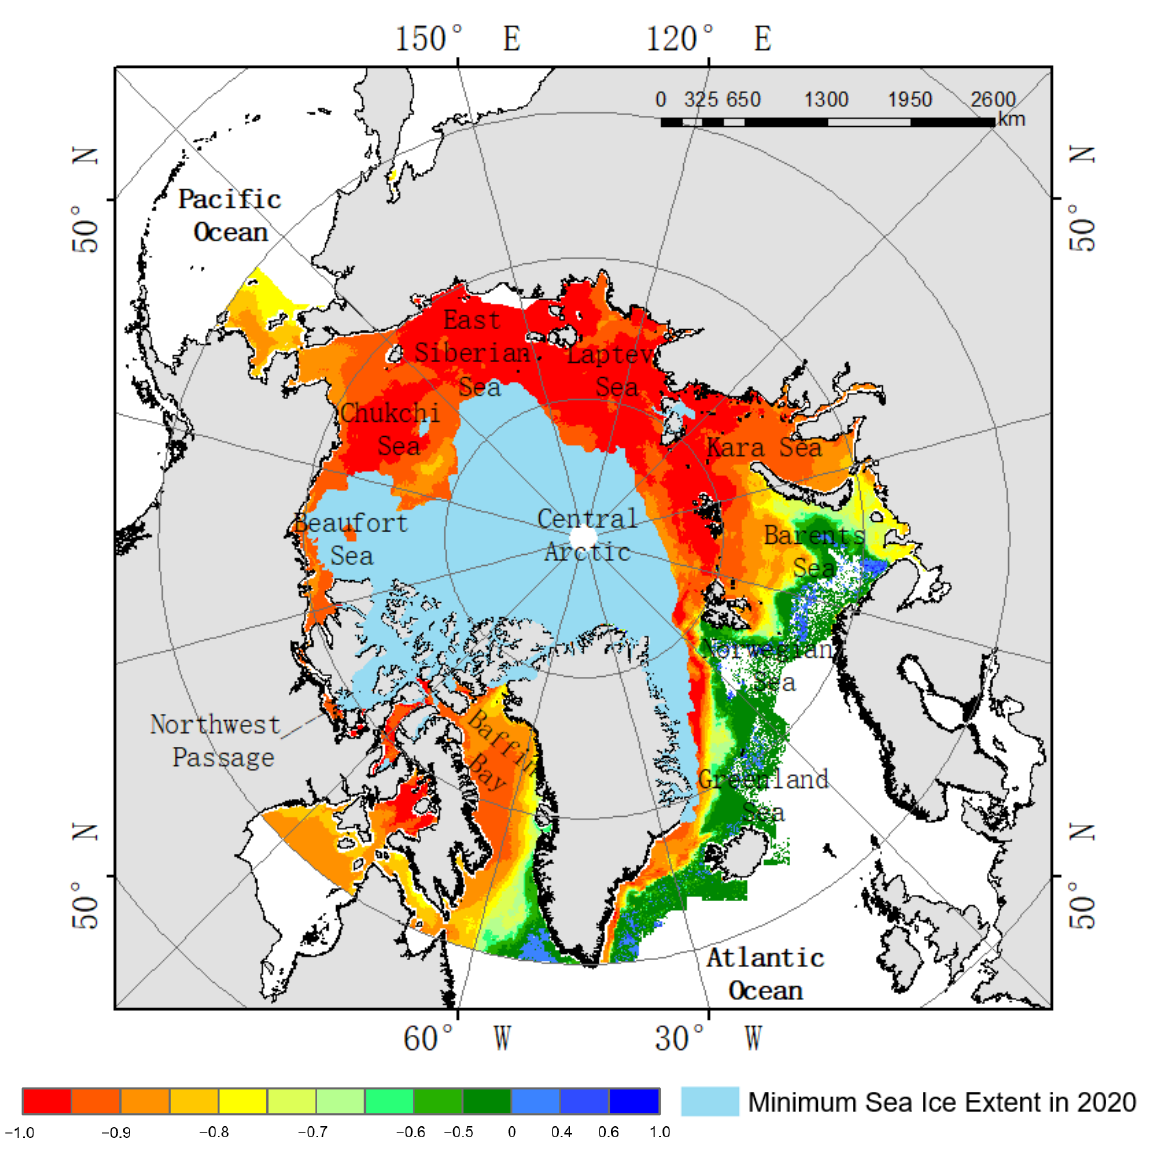
Figure 6. Correlation coefficient of SIC and SST in the Arctic from 2002 to 2021.